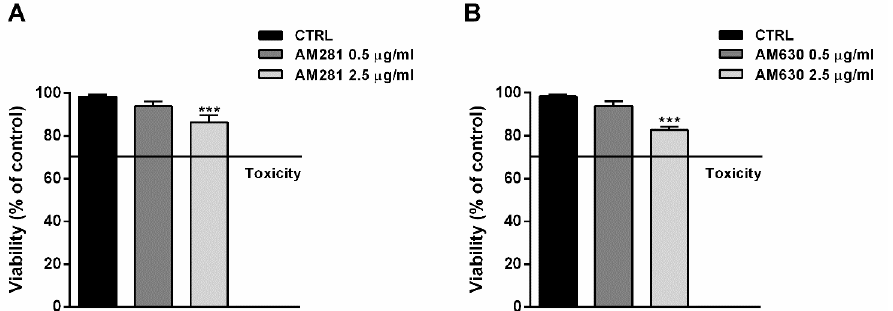
Figure 5. Effect of AM281 ( A ) and AM630 ( B ) antagonists on the viability of MDA-MB-468 breast cancer cells. The cells were treated with antagonists for 1 h, then washed and further incubated for 24 h. Data are expressed as mean ± SEM of at least three independent experiments with three technical replicates ( n = 9); *** p < 0.001, significant difference respect to the control (ANOVA + Dunnett’s Multiple Comparison PostTest).